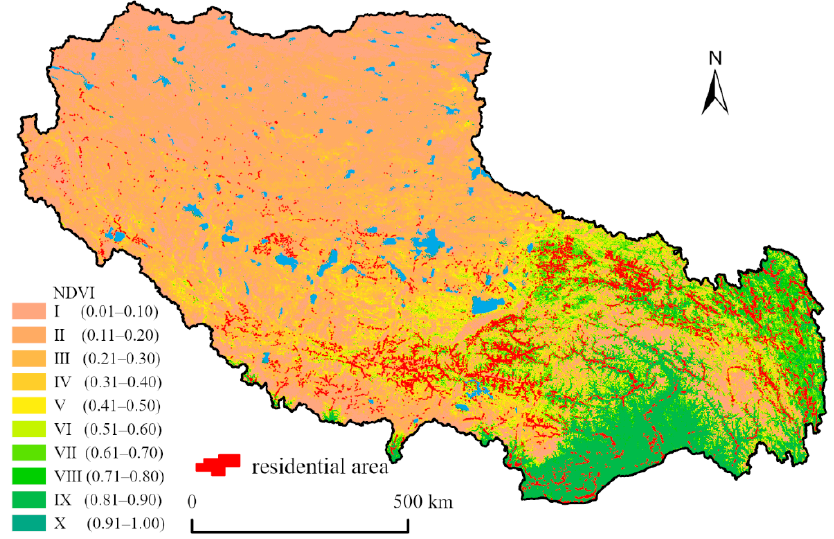
Figure 6. Spatial location map of Tibetan residential area and NDVI.